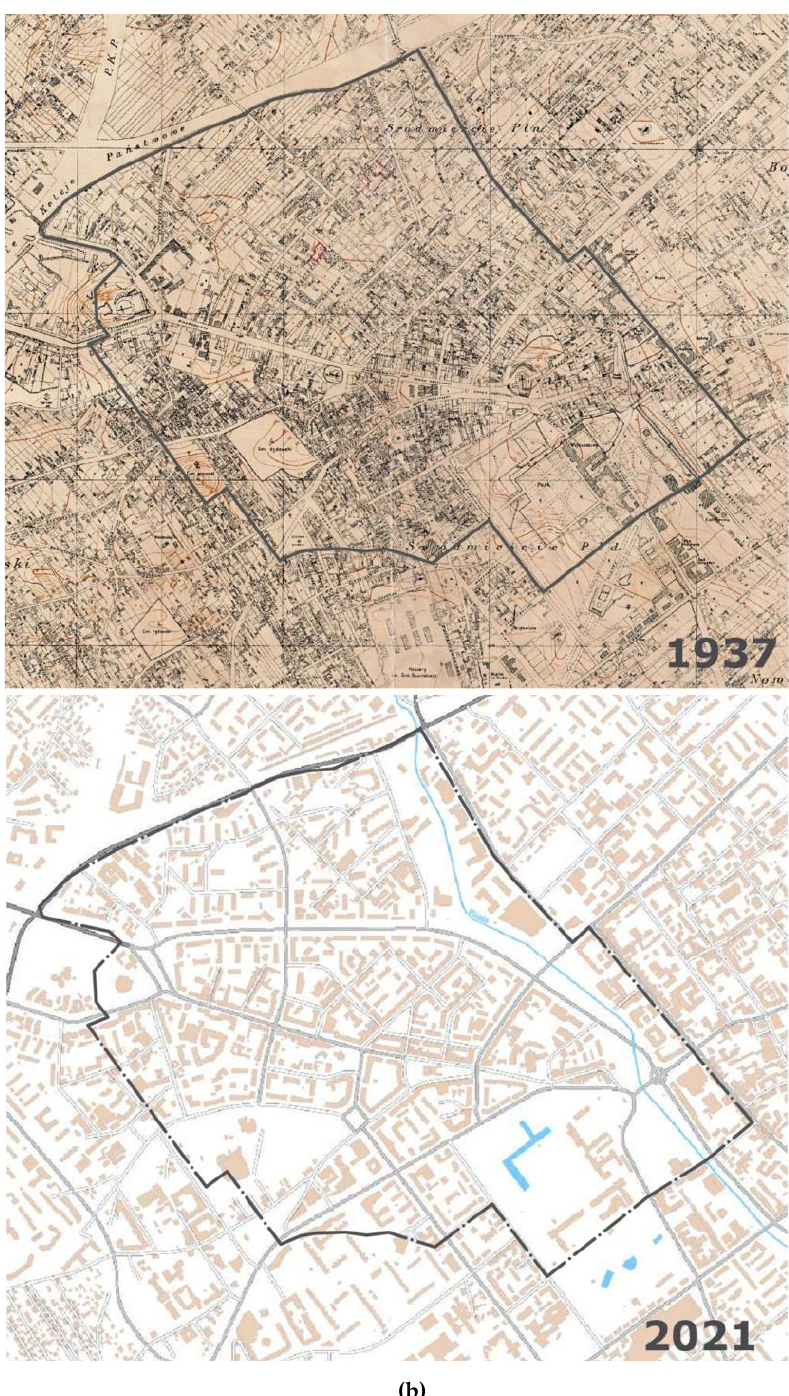
Figure 3. (a) The research area: location of the war damage; prepared by M. Chodorowski based on materials of Białystok Municipality. (b) Research area on maps of 1937 and 2021; source: (1937) National Archives in Białystok, The Plan of the District City Białystok 1937, (2021) based on Białystok Geographic Information System.